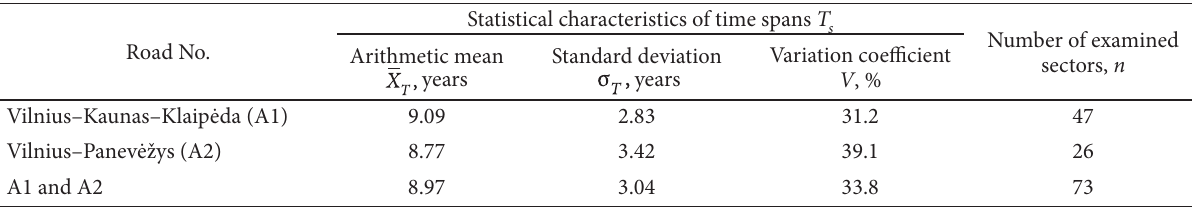
between HMA pavement structure repairs s